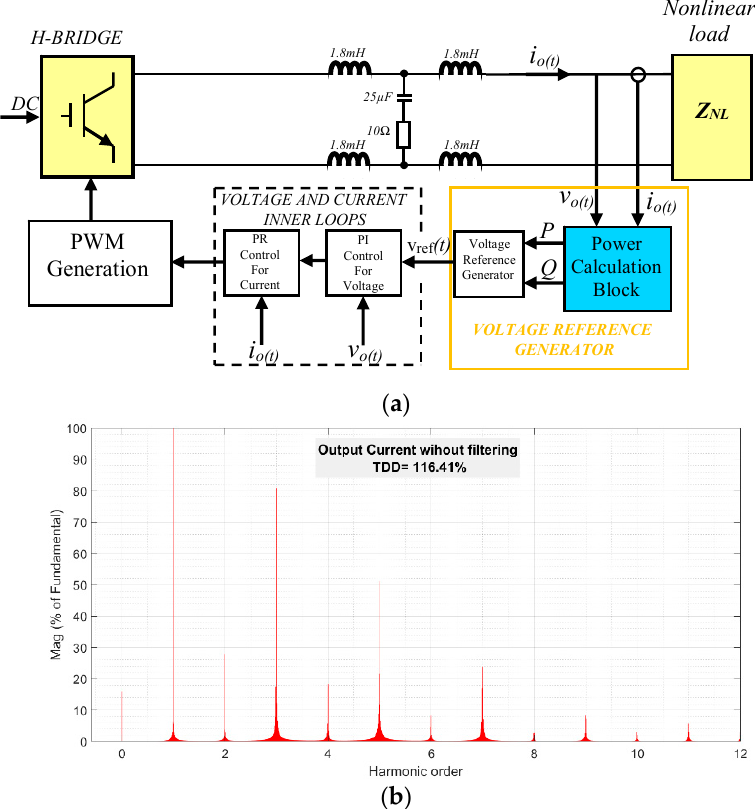
Figure 3. Scheme of a VSI with the existing approaches and the load’s distorted current: ( a ) block scheme of a single-phase VSI, showing the inner control loops of current and voltage, fed with the voltage reference generated by utilizing the Voltage Reference Generator block, based on References [45,53]; ( b ) nonlinear current harmonic distribution for Z NL without filtering, after S0 is turned on.